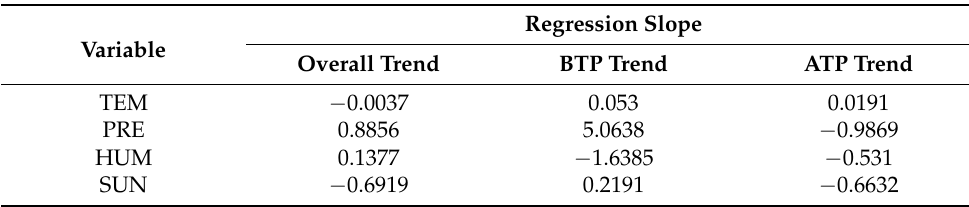
Table 1. Regression slope, including the overall trend, BTP trend, ATP trend, TEM, PRE, HUM, and SUN at the regional scale for the whole study area. Regression Slope Variable Overall Trend BTP Trend ATP Trend TEM − 0.0037 0.053 PRE